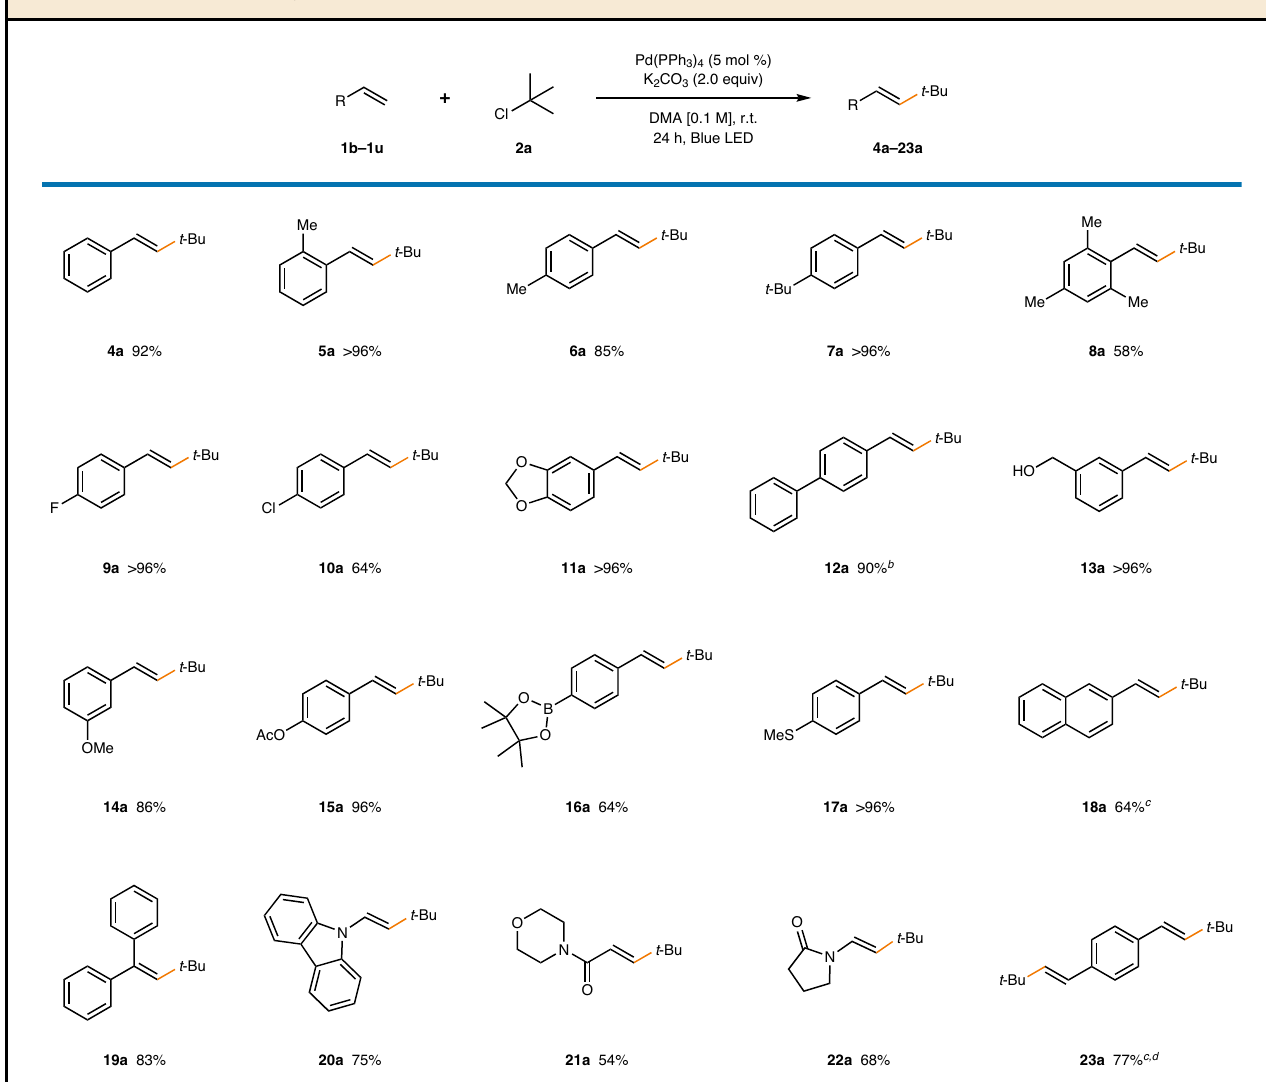
Table 3 Ole fi n substrate scope a